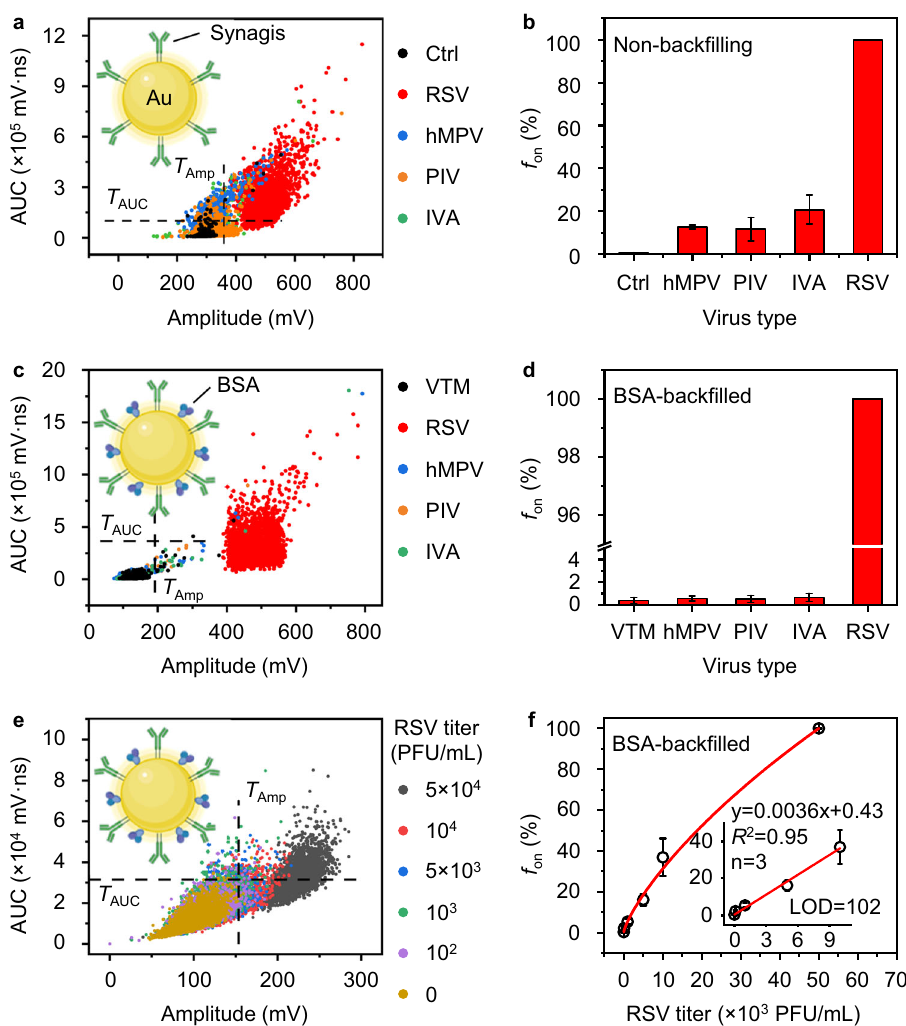
Fig. 6 Detection of RSV among closely related respiratory viruses by DIAMOND. a , c , e Bivariate plots of amplitude and AUC extracted from 3000 pulses for the assay solutions incubating a AuNP-Synagis probes with different respiratory viruses, c bovine serum albumin (BSA)-back fi lled AuNP-Synagis probes with different respiratory viruses spiked in the nasal swab samples, and e BSA-AuNP probes with RSV of different titers (PFU/mL) spiked in the nasal swab samples. b , d , f The corresponding f on counted from a , c , e against b , d different respiratory viruses and f RSV with different titers, respectively. VTM: viral transport medium. Insets in ( a , c , e ) show the schematic of AuNP-based probes used correspondingly. Inset in ( f ) shows the linear detection range and LOD. Error bars in ( b ), ( d ), and ( f ) indicate the standard deviations of three independent